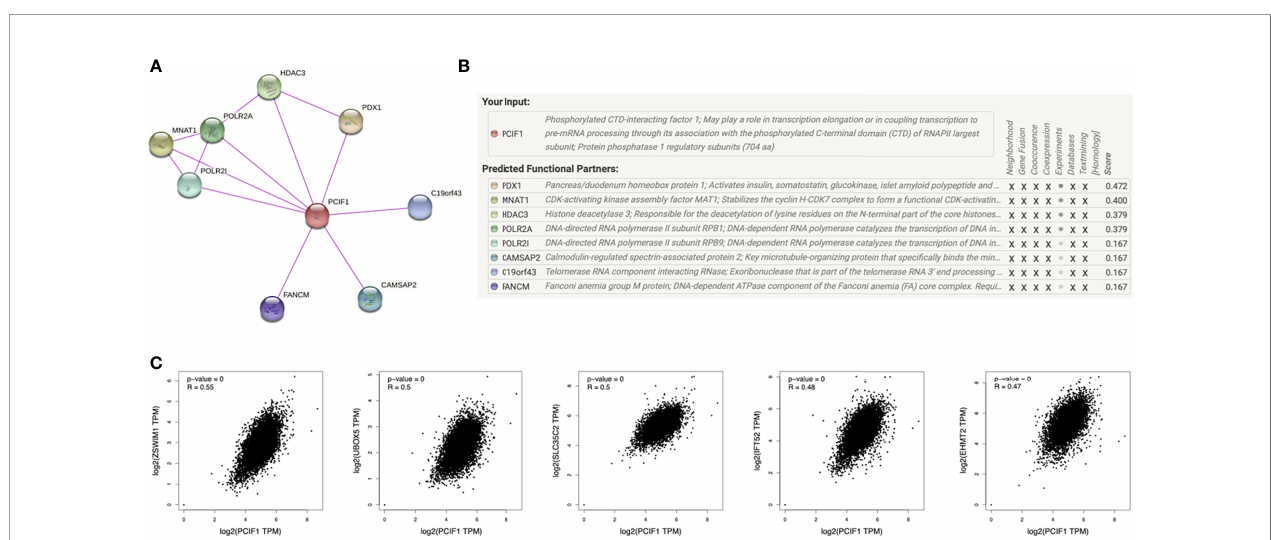
FIGURE 8 | PCIF1-related gene enrichment analysis. (A, B) Experimentally interacted proteins of PCIF1 obtained by STRING. (C) Correlation between PCIF1 and top 5 PCIF1-correlated genes (ZSWIM1, UBOX5, SLC35C2, IFT52, RHMT2) interacted proteins obtained by